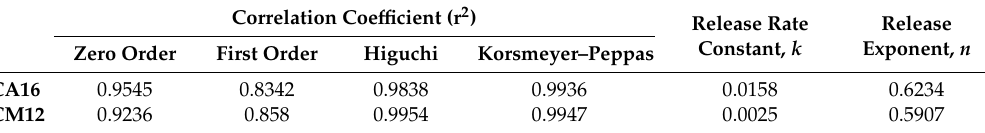
Table 4. Drug release correlation coe ffi cient values from di ff erent kinetic